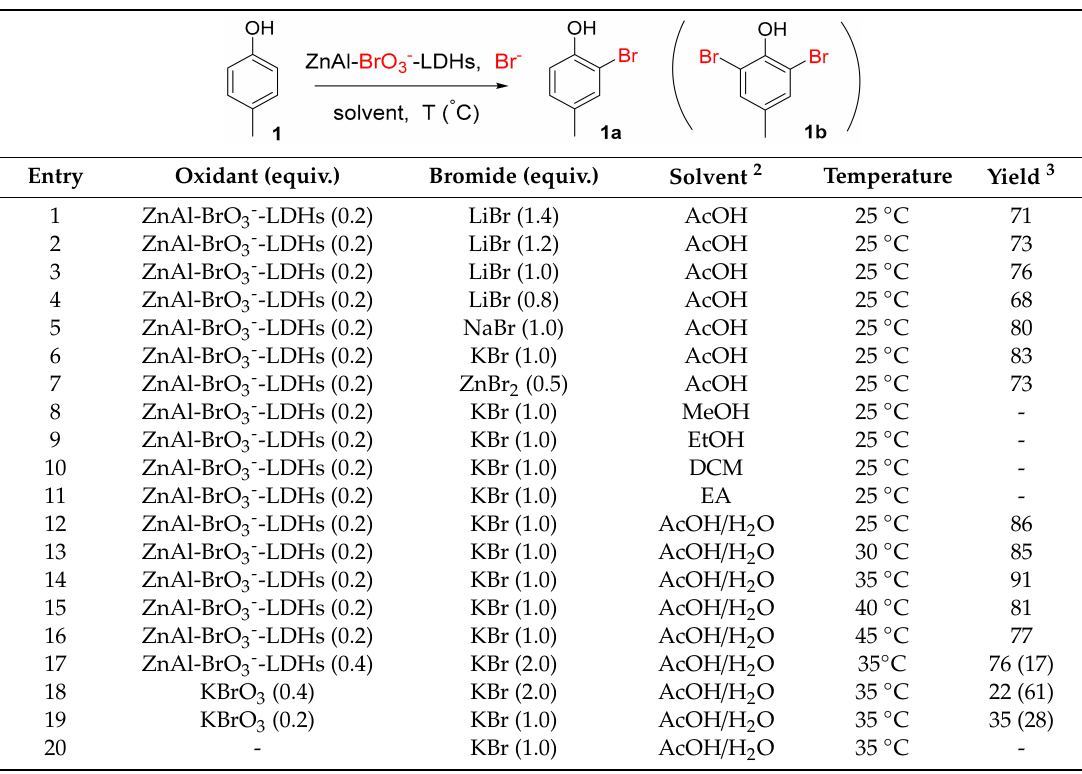
Table 1. Optimization of bromination.